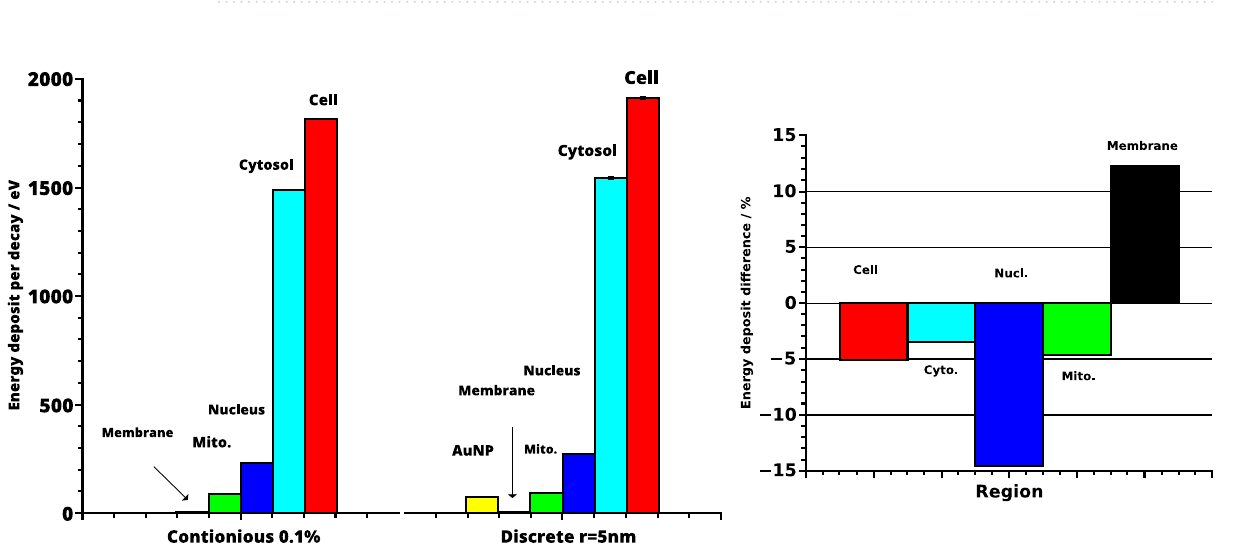
Figure 2. Left: Energy deposit per decay in the respective region of the cell for the continuous model with m Au = 0.1% and the discrete-geometric model for r AuNP = 5 nm. Energy deposit in the cell and cytosol include the energy deposit in the AuNP. The errorbars represent the standard deviation for n = 10 simulations each. They are in the size of the line thickness and therefore not visible. Right: Relative change of the energy deposit in the continuous model with respect to the discrete-geometric